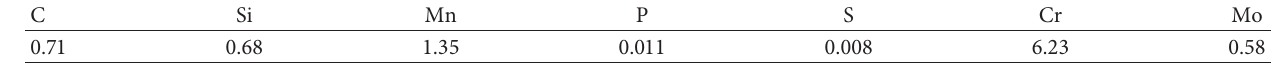
Table 1: Chemical composition (in wt%) of the welding wire used in this work for WAAM.